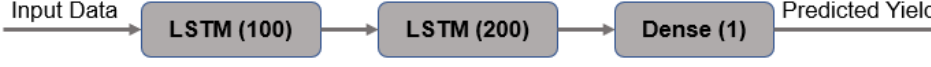
Figure 9. Architecture of unimodal and bimodal deep learning